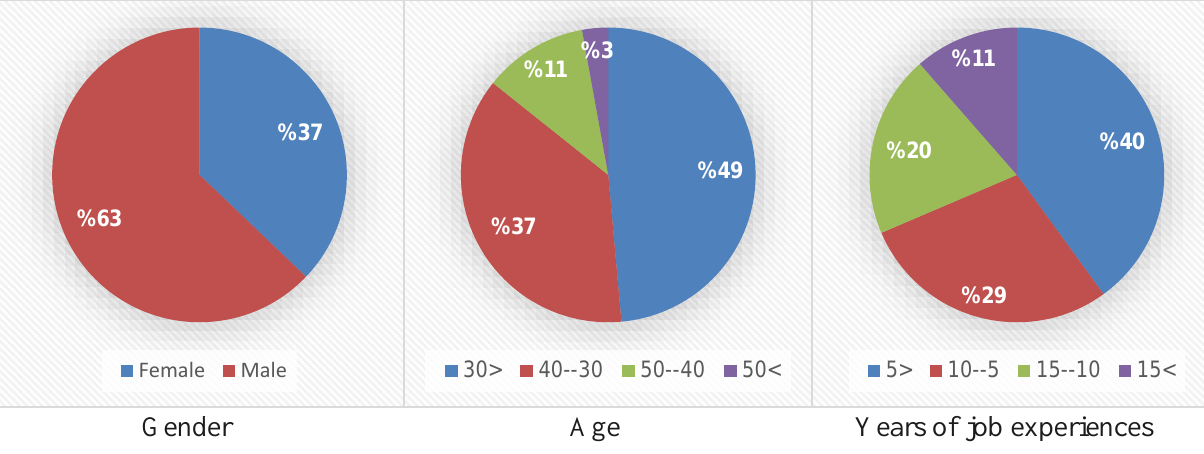
Fig. 1. Personal characteristics of the